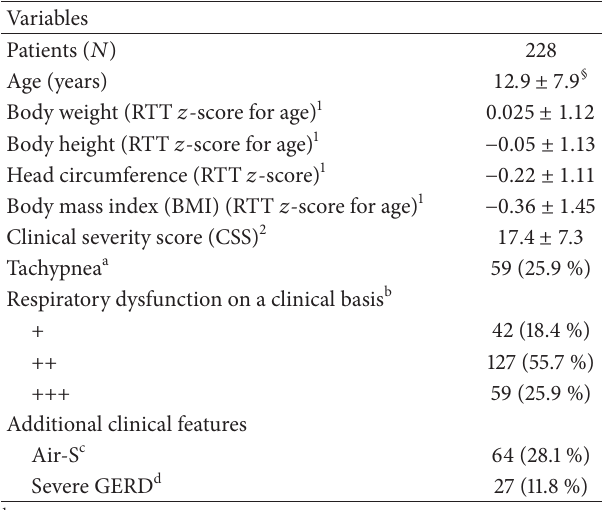
Table 1: Relevant demographic and clinical characteristics of female subjects with Rett